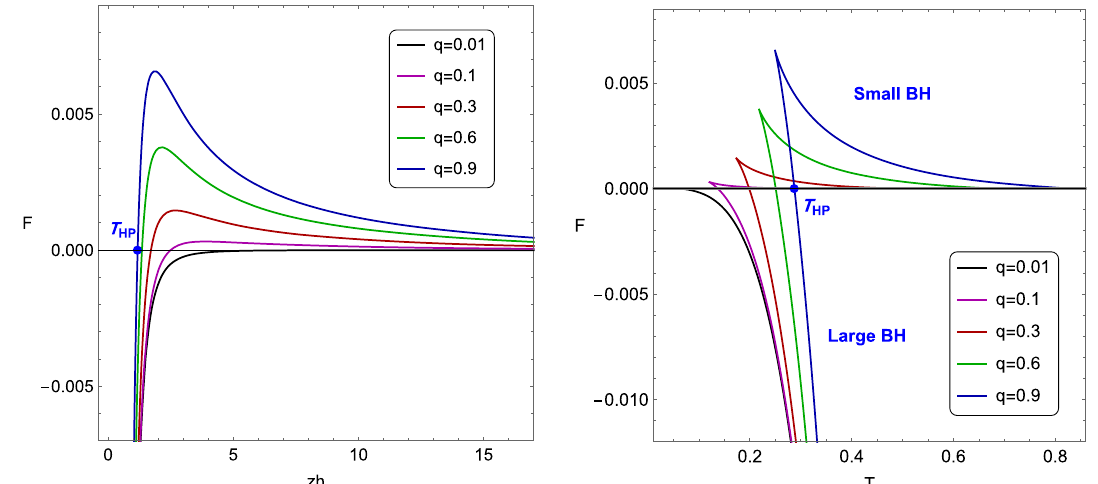
Fig. 2 Left: Free energy of the black hole F as a function of the hori- zon z h for different values of charges. We have normalized the free energy such that it vanishes when z h → ∞ . Right: Free energy of the black hole F as a function of the temperature T for different values of